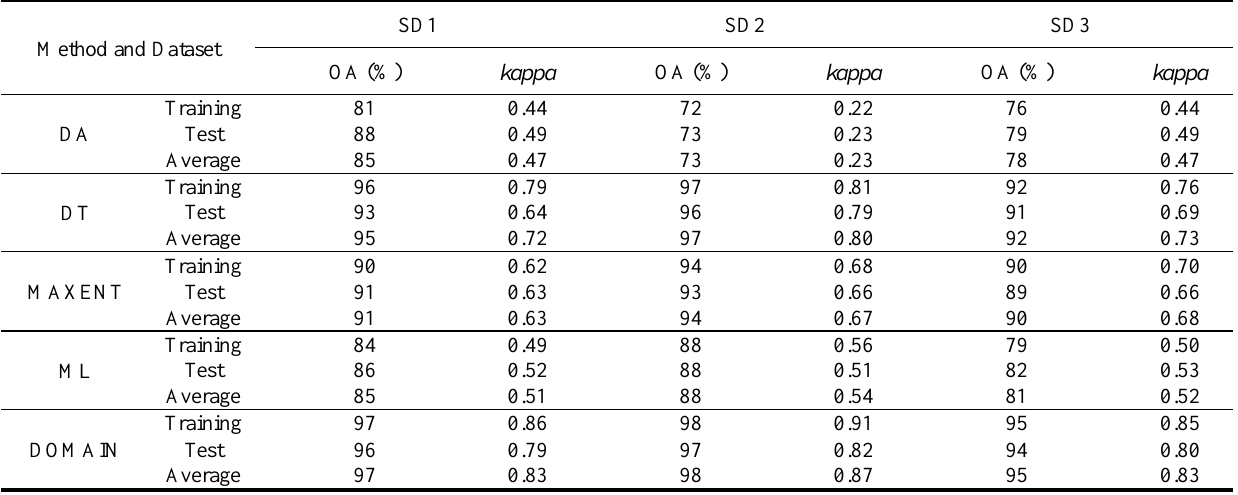
Method and Dataset